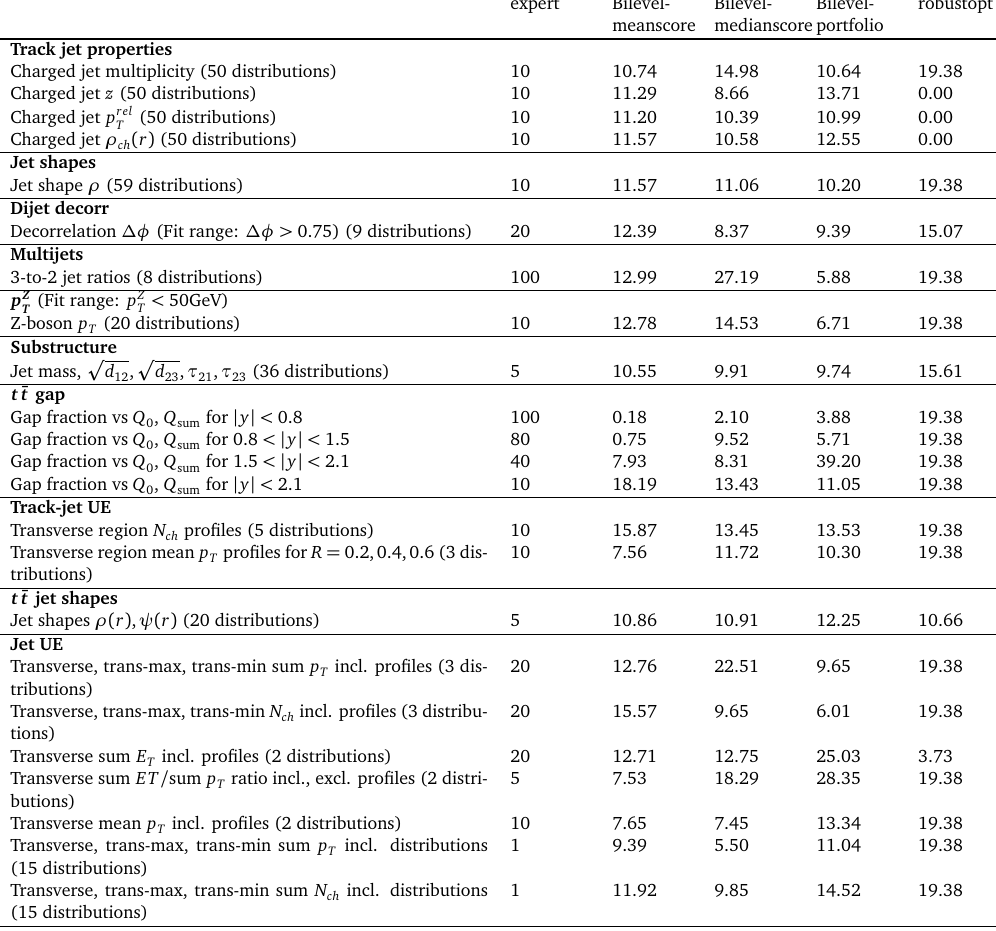
Table 26: Comparison of the optimal weights obtained by each method using the cubic polynomial approximation. The observable grouping corresponds to the same grouping used in [ 3 ] .